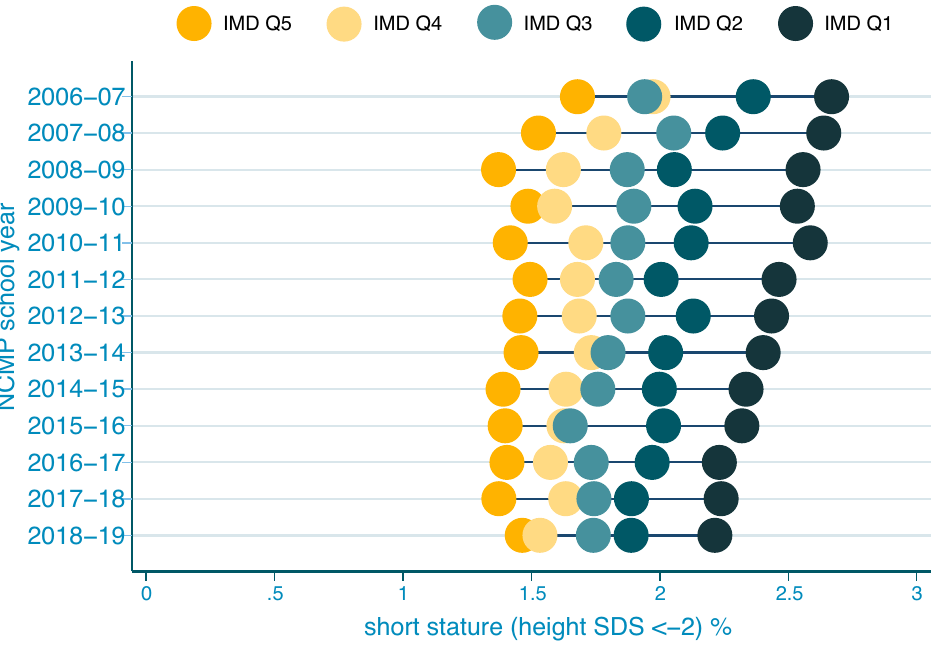
Fig 2. Equiplot of short stature percentage by IMD quintile and NCMP school year. IMD Q refers to IMD quintiles, where IMD Q1 is the most deprived quintile, and IMD Q5 is the least deprived quintile. IMD, index of multiple deprivation; NCMP, National Child Measurement Programme; SDS, standard deviation score.